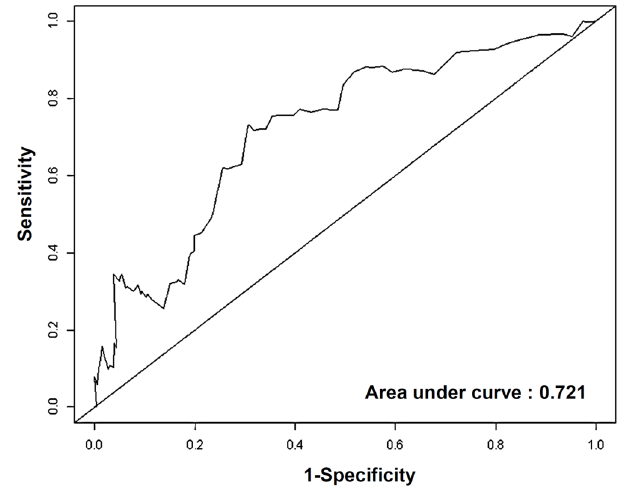
Figure 1. Time-dependent ROC curve for recurrence-free survival (n=305).